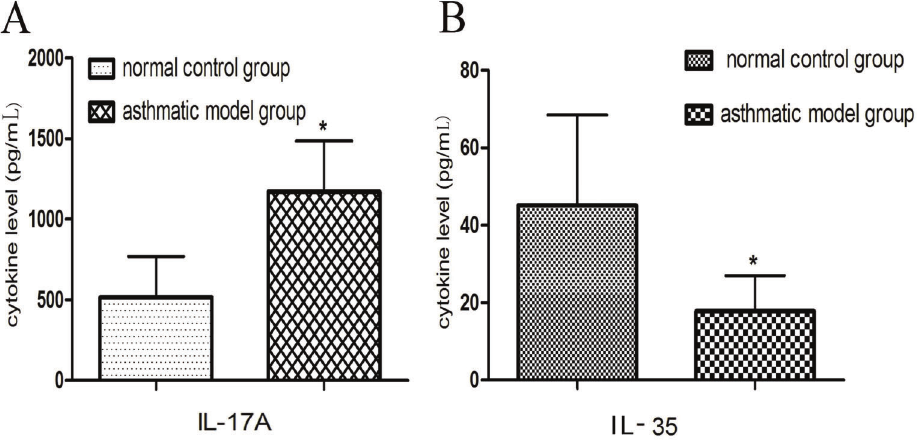
Figure 5. Concentrations of interleukin (IL)-17A ( A ) and IL-35 ( B ) in bronchoalveolar lavage fl uid (BALF) were examined by ELISA using speci fi c cytokine detection kits. Data are reported as means ± SD. *P o 0.05 vs the normal control group ( t